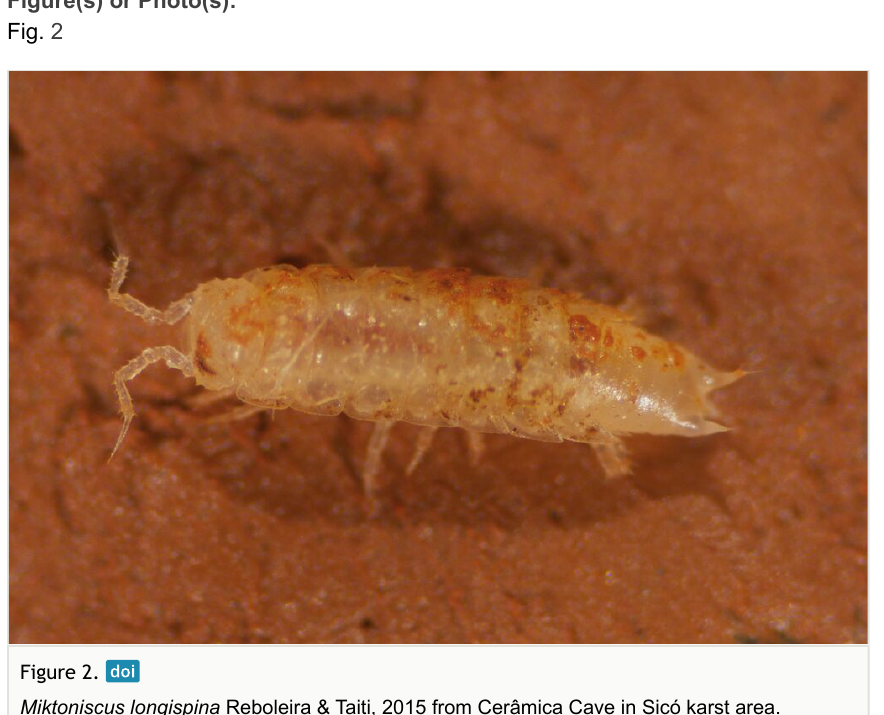
Figure(s) or Photo(s):